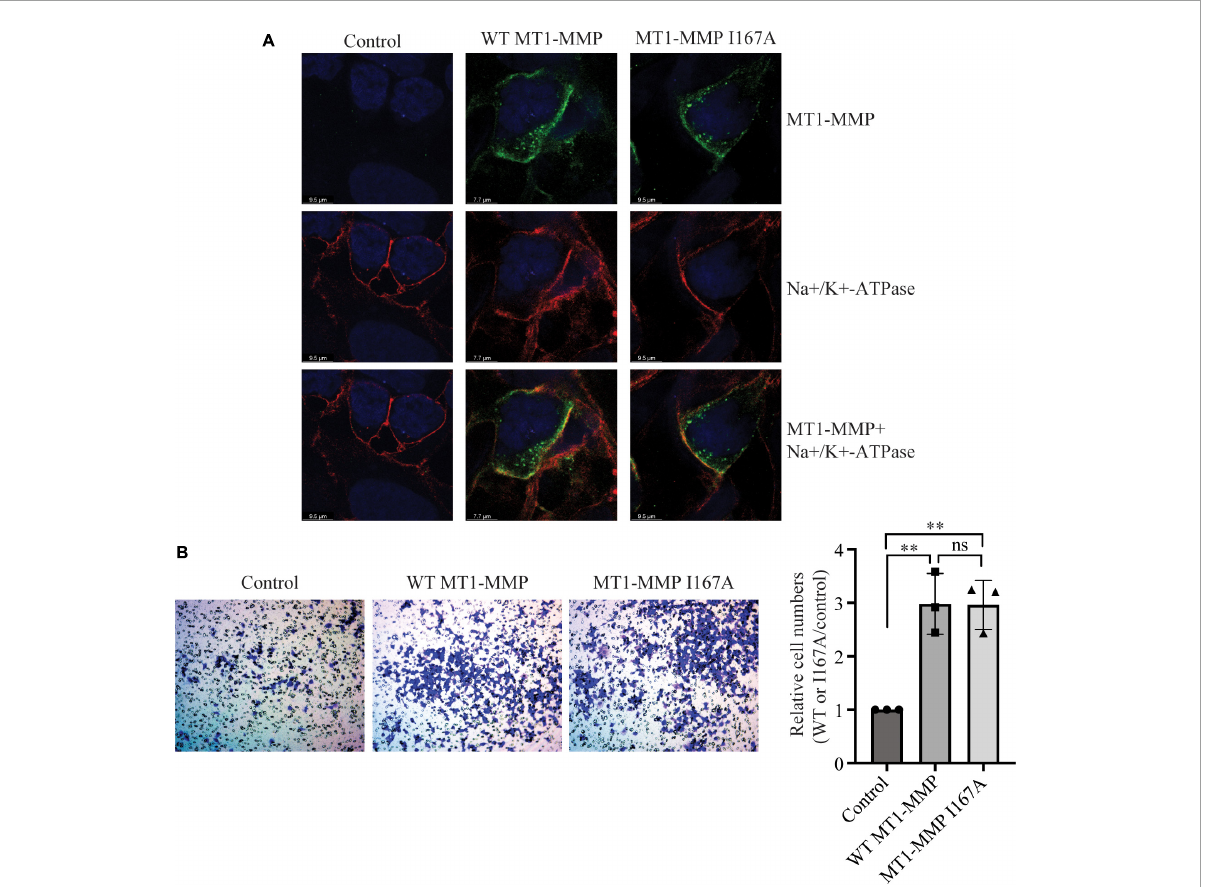
FIGURE5 Effects of I167A on MT1-MMP trafficking and cell migration (A) Confocal microscopy. HEK293 cells transfected with empty plasmid (Control) or plasmid containing the HA-tagged wild-type or I167A mutant MT1-MMP were subjected to confocal microscopy. MT1-MMP was detected with a rabbit anti-HA polyclonal antibody (Proteintech, 51064-2-AP) and showed in green fluorescence (top and bottom panels). Na + /K + -ATPase was detected by a mouse monoclonal antibody and showed in red fluorescence (middle and bottom panels). Nuclei were visualized with DAPI (blue). An x-y optical section of the cells illustrates the distribution of the wild-type and mutant proteins (magnification: 325X). (B) Transwell assay. HEK293 cells were transfected with empty plasmid (Control) or plasmid containing the HA-tagged wild-type or I167A mutant MT1-MMP using Lipofectamine 3000 and then placed on a collagen type I-coated insert. 48 h after, cells were stained with crystal violet. Cells on the bottom of the insert were imaged, counted, and then divided by the image area. Relative cell numbers were the ratio of the cell numbers of cells transfected with the wild-type or I167A MT1-MMP to that of cells transfected with the empty vector (control), which was defined as 1. Representative images were shown. Values were mean ± S.D. of 3 experiments. The significant difference between two groups (wild type or mutant MT1-MMP vs. the Control) were determined via Student’s t -test. ns (no significance), p > 0.05, ** p <